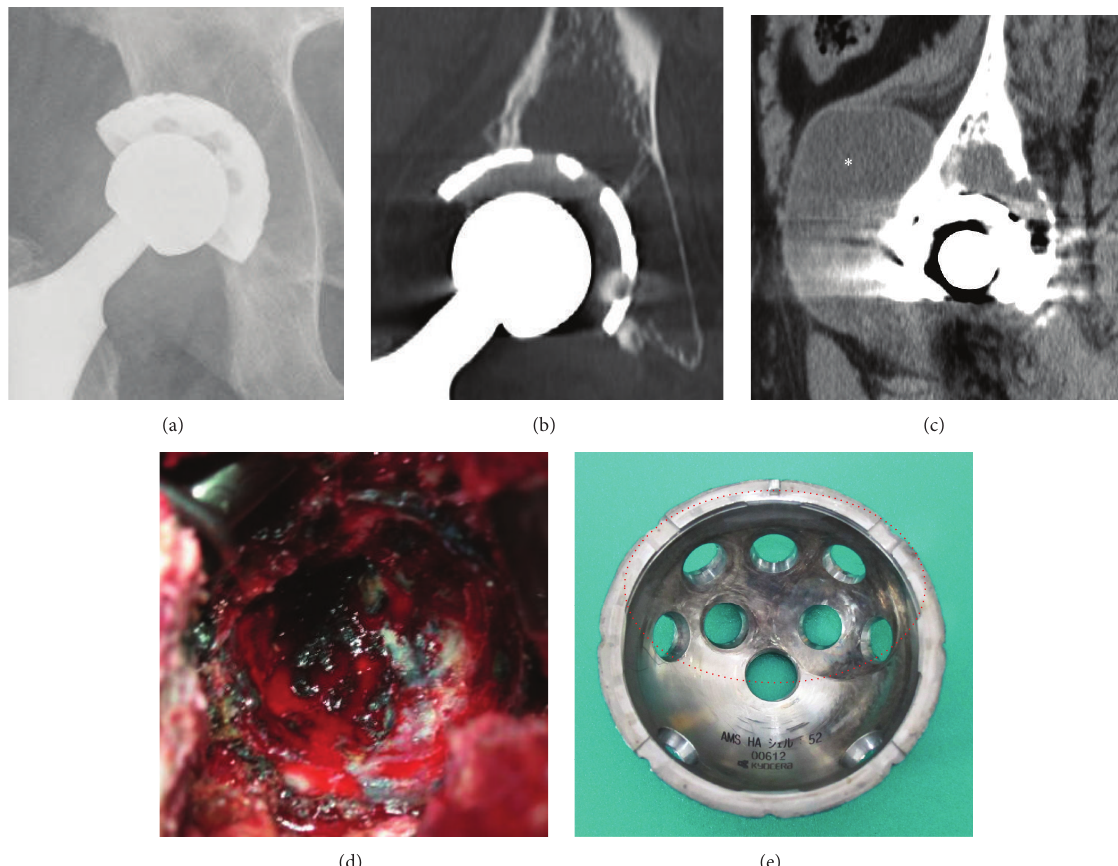
Figure 2: An anteroposterior view of plain radiograph (a) and a CT coronal image (b) showing the expanding retroacetabular osteolysis. A pseudotumor at the anterior aspect of the right hip (asterisk) connected to the hip joint was observed in a CT sagittal image (c). Pigmentation of metallic debris inside the osteolytic lesion and around the joint capsule and acetabulum was seen intraoperatively (d). A photograph of the retrieved cup (e) showing abrasion inside the metallic shell connecting to polyethylene liner (dotted